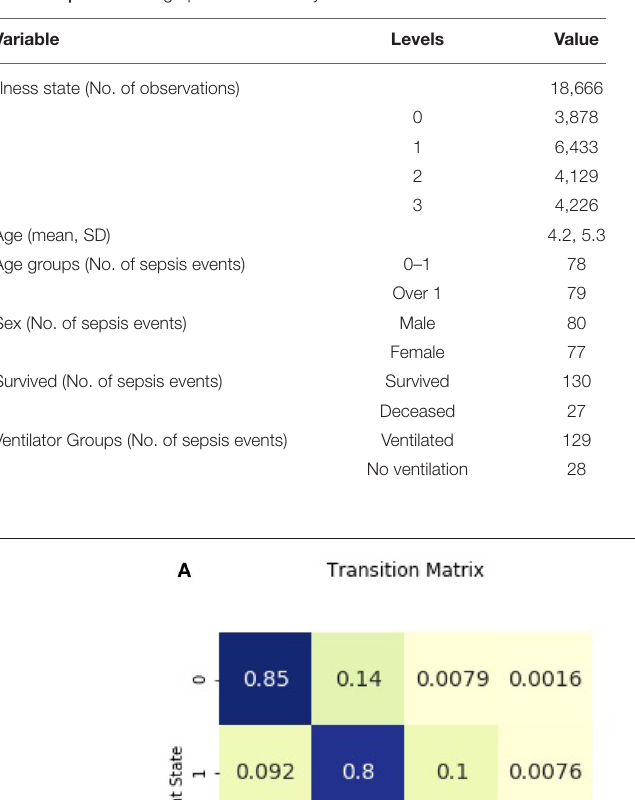
TABLE 1 | Sociodemographics of the study cohort.